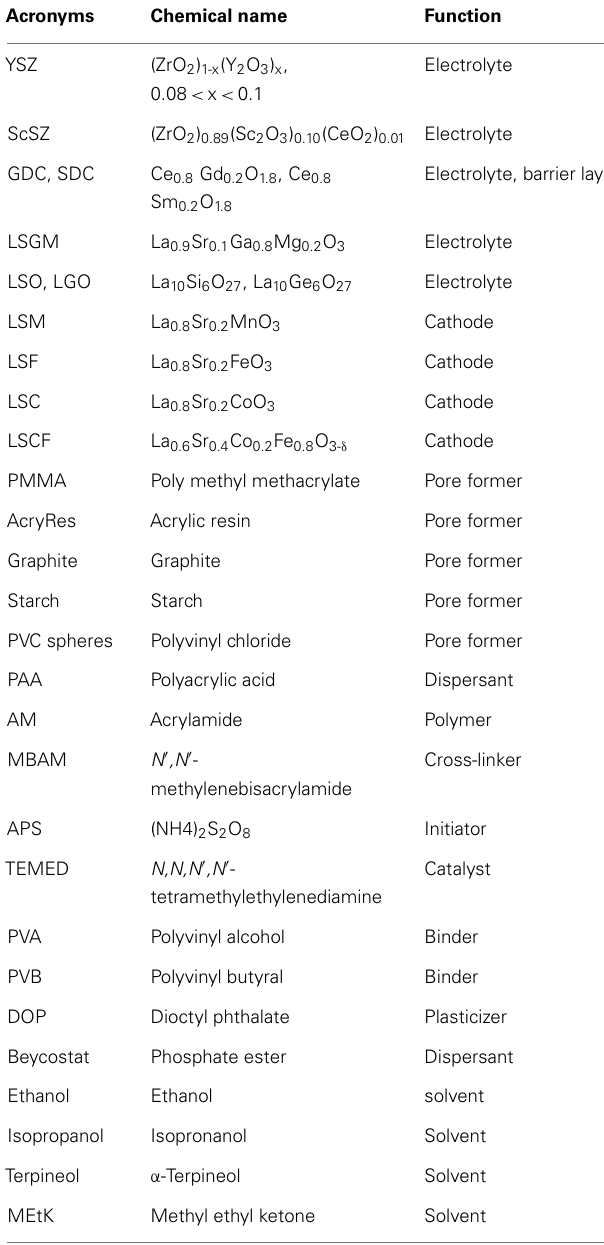
Table 3 | Most frequently used components of mT-SOFCs